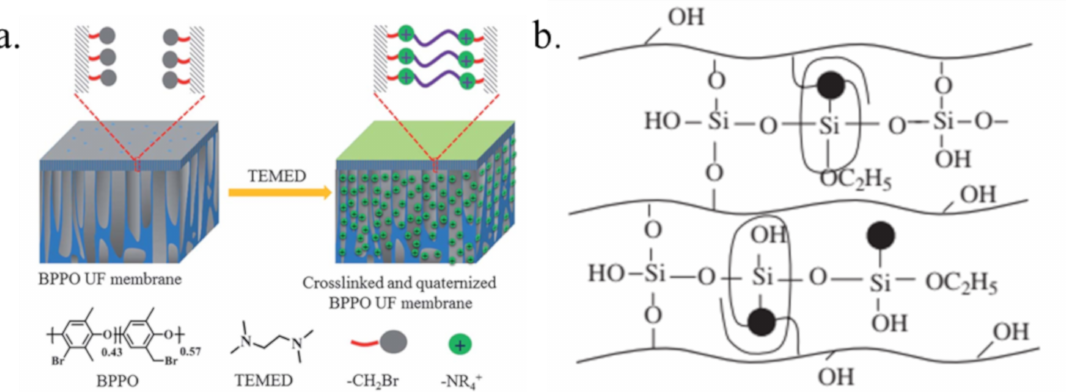
Figure 8. Schematic diagram of the preparation of crossliked and quaternized BPPO ultrafiltration membrane ( a ) and the structure of quaternized poly(2,6-dimethyl-1,4-phenylene oxide) (QPPO) and PVA-based membrane ( b )